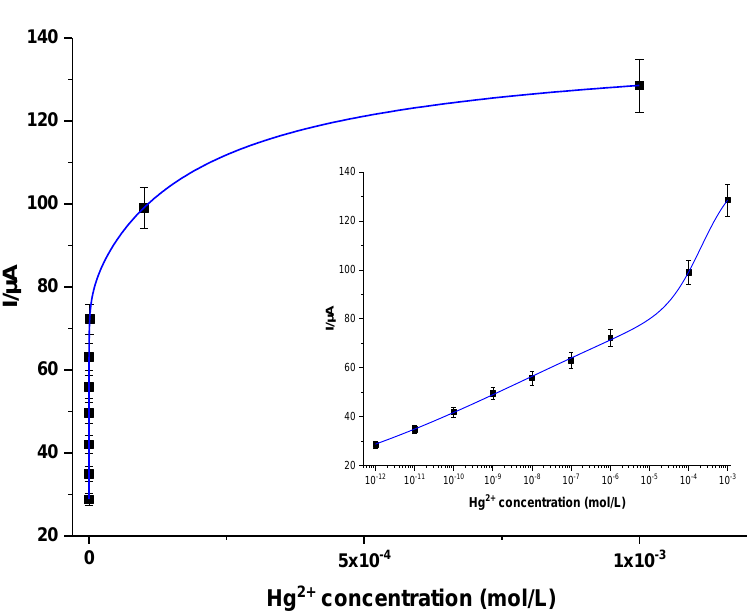
Figure 11. Peak current variation versus Hg 2+ concentration; electrochemical experimental data were fitted by a combined model (one binding site + Hill model). The inset is added to highlight the goodness of the fit according to the proposed model.